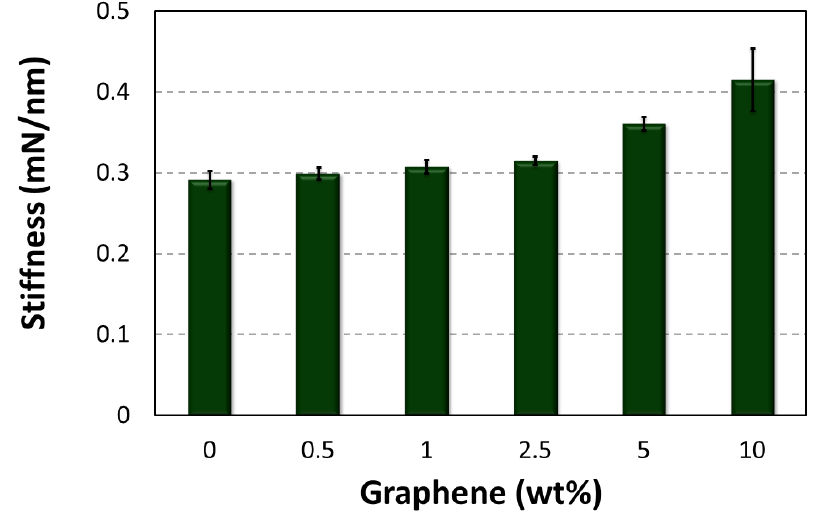
Figure 15. Effect of graphene additives on stiffness.